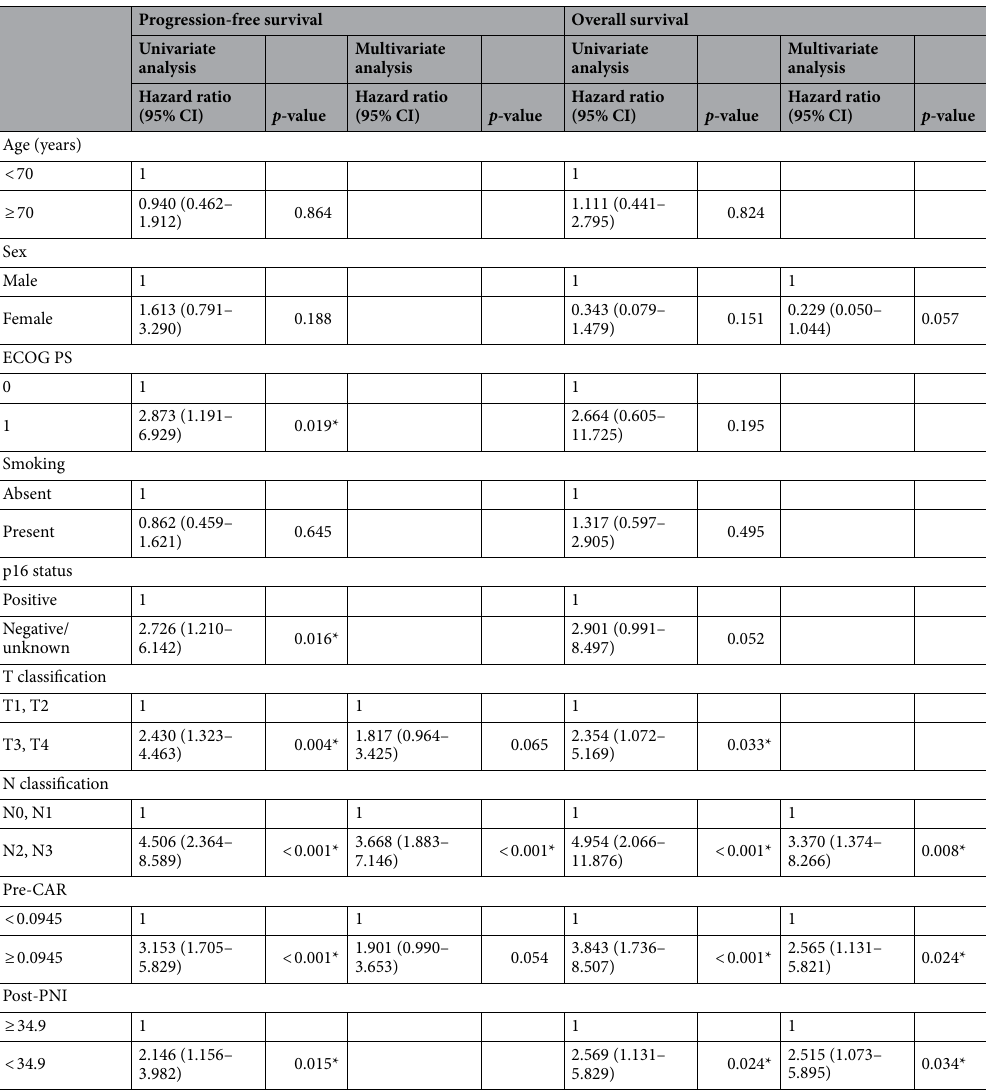
Table 2. Univariate and multivariate analyses of overall survival and progression-free